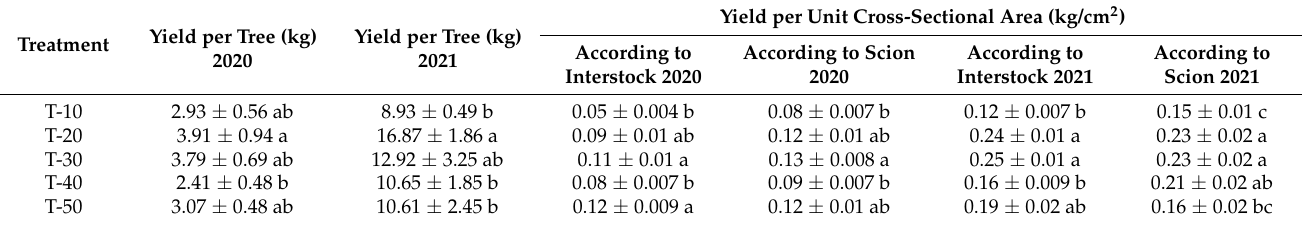
Table 5. Effects of different dwarfing interstock lengths on yield (2020 and 2021).